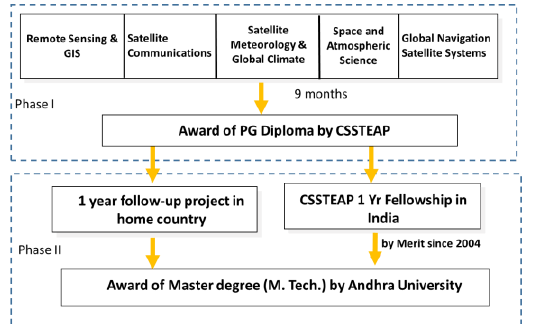
Figure 2. T he schematic of procedure followed by